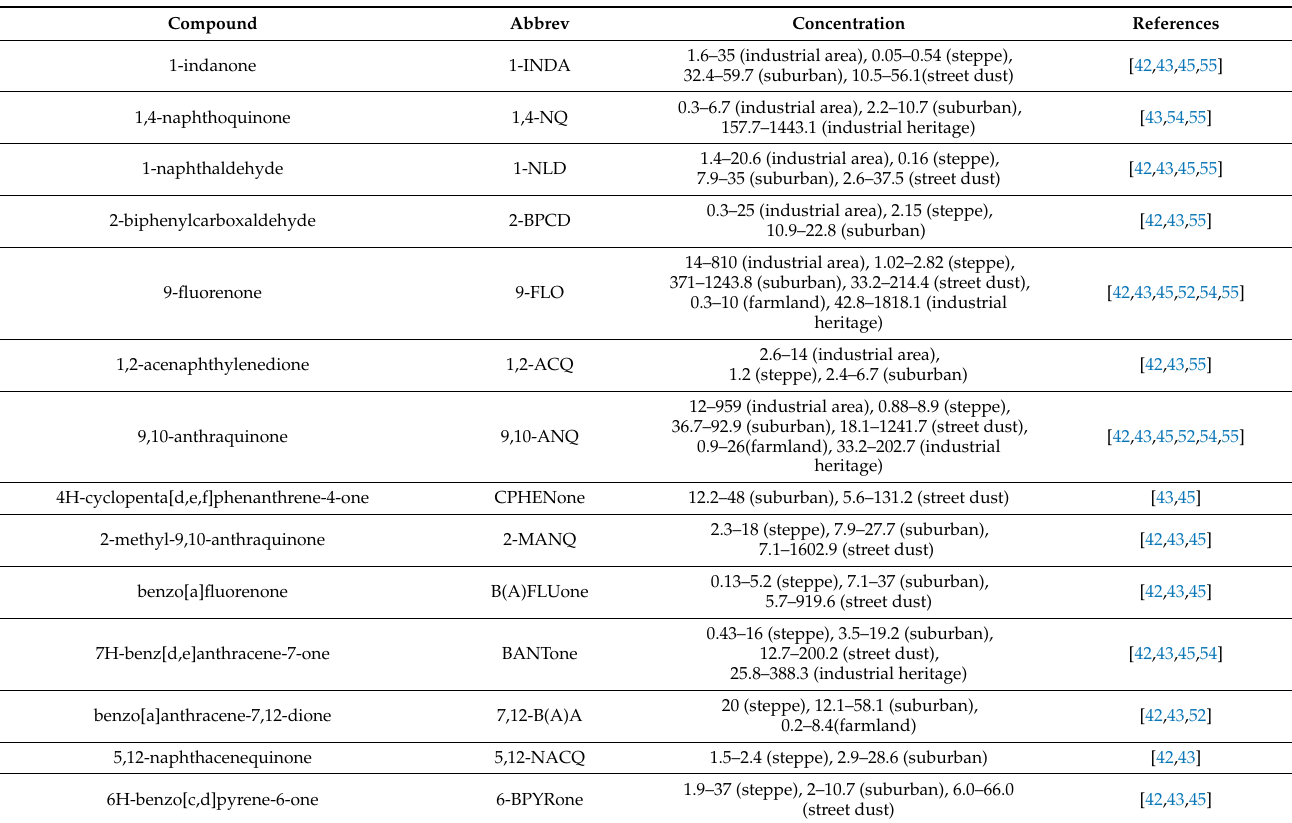
Table 2. Research status of individual OPAH in